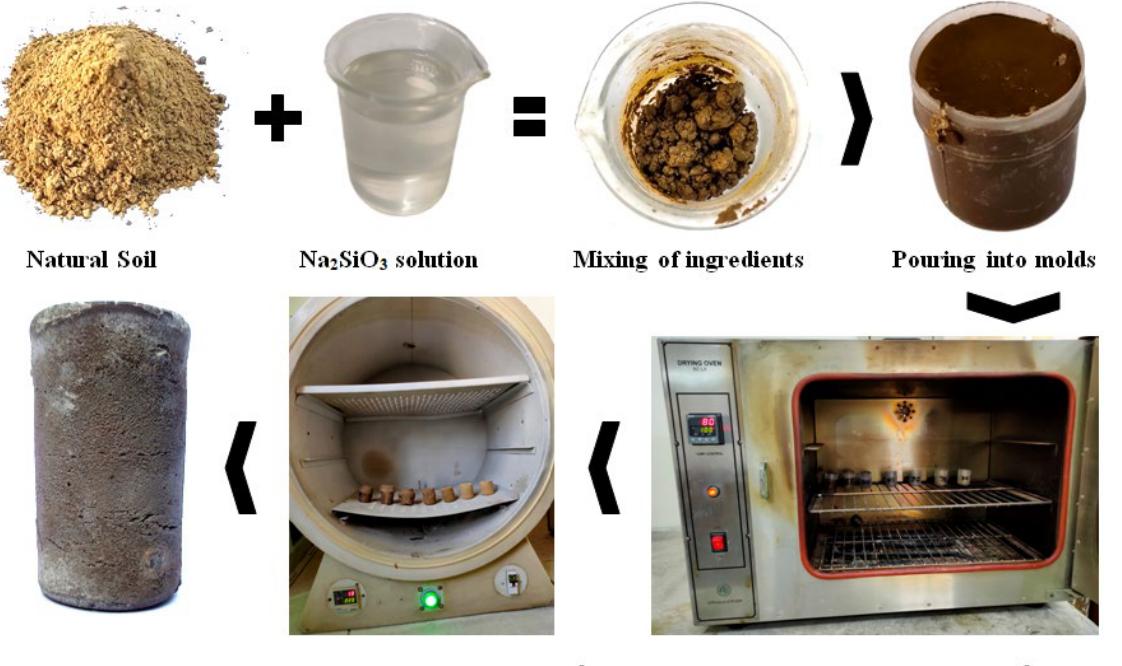
Figure 2. Process flow chart for the preparation of GP samples.